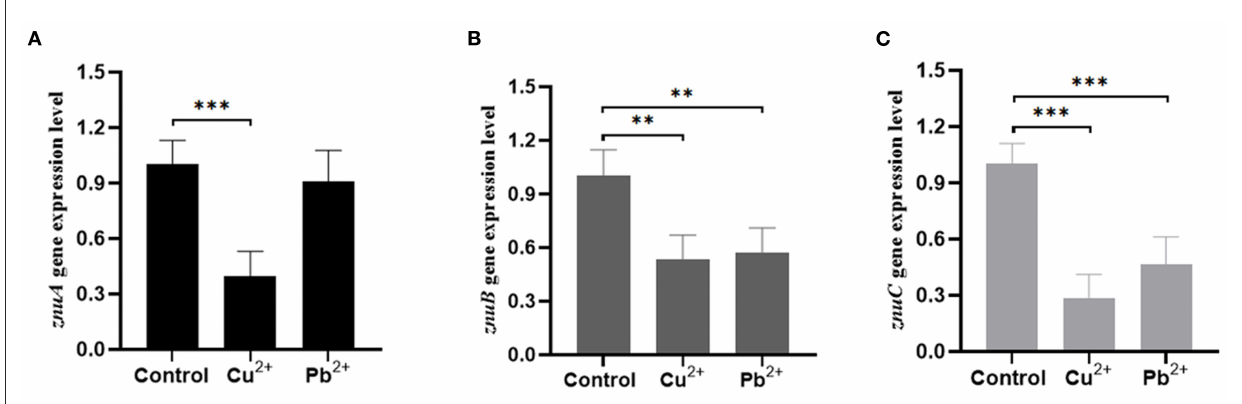
FIGURE10 The expression levels of znuA , znuB and znuC gene under different heavy metal ion stresses. (A) was the expression levels of znuA under Cu 2 + and Pb 2 + stresses; (B) was the expression levels of znuB under Cu 2 + and Pb 2 + stresses; (C) was the expression levels of znuC under Cu 2 + and Pb 2 + stresses. Data were presented as mean ± standard deviation (SD) ( n = 3). ** P < 0.01, *** P <